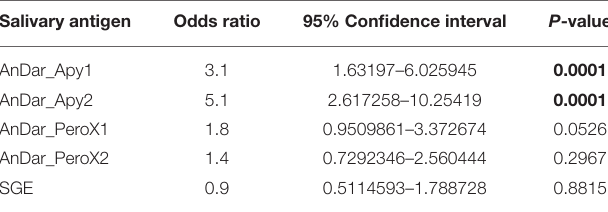
TABLE 5 | Odds ratio calculations to measure risk of malaria infection based on level of IgG antibodies against An. darlingi salivary proteins. Salivary